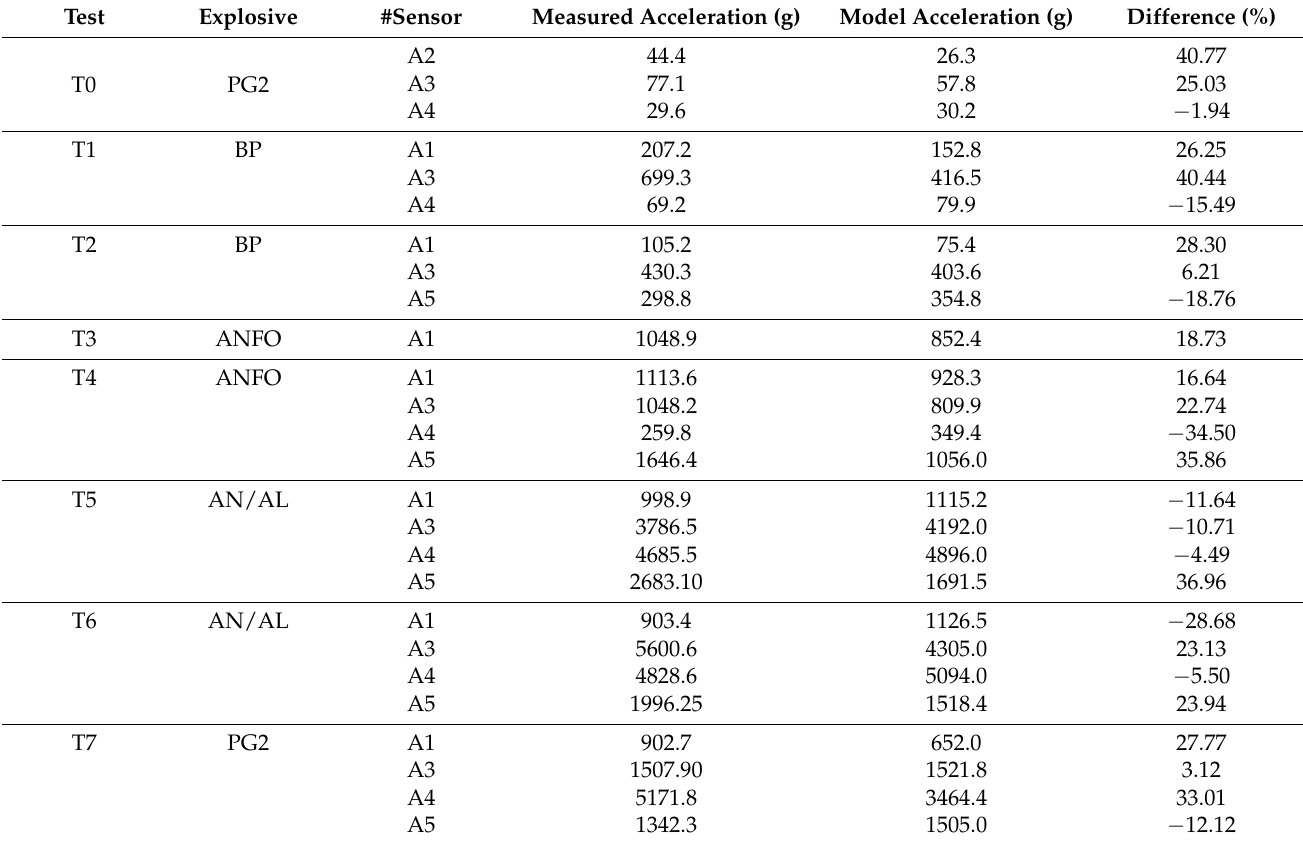
Table 5. Peak acceleration values for different sensors and trials. BP means black